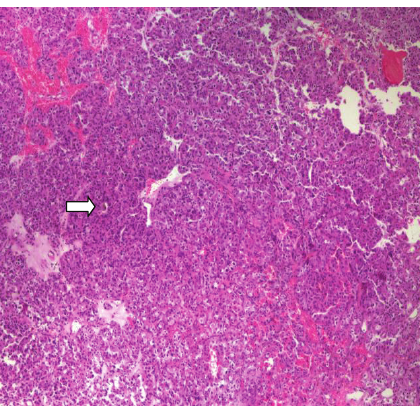
Figure 1: Biopsy material consisted of neoplastic cells arranged in cords (H-EX4). Focal presence of hemosiderin deposition (arrow).